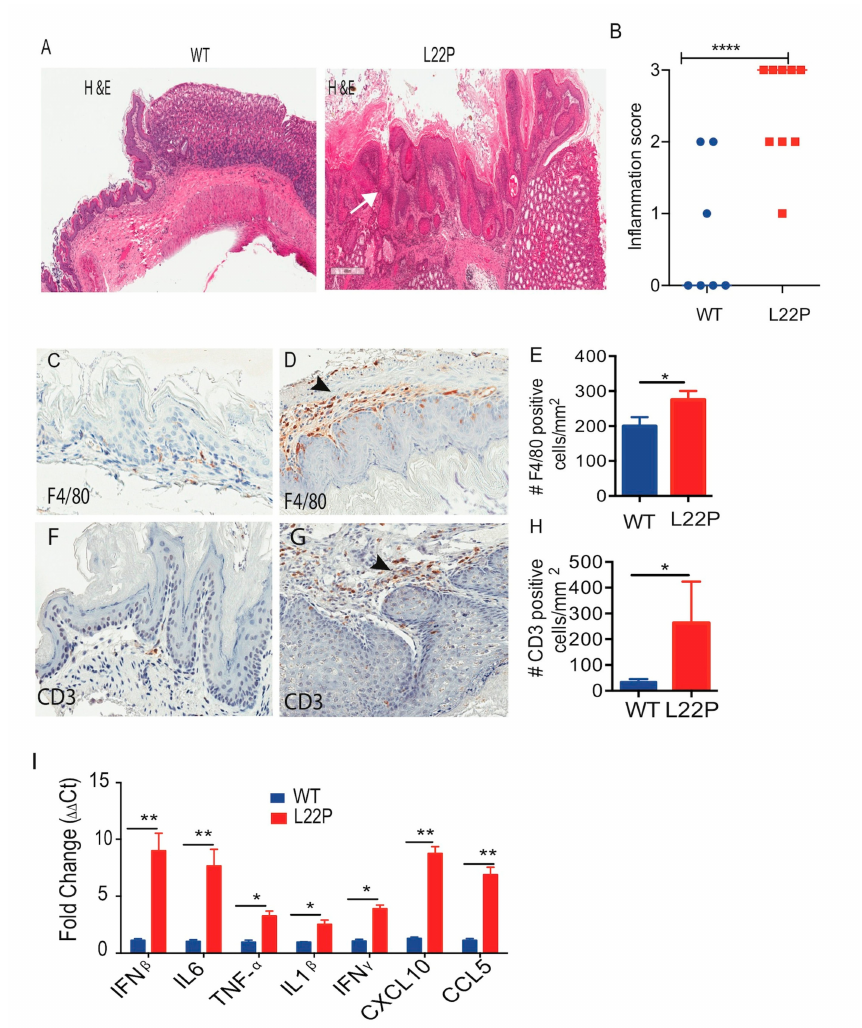
Figure 6. L22P increases susceptibility to gastric inflammation in mice. ( A ) Representative image of gastrichistopathologyofwildtype(WT)andL22PC57Bl / 6micewithHandEstaining; ( B )Quantification of inflammatory score between WT (seven mice) and L22P mice (nine mice) stomach tissue sections; Low-to-medium-grade inflammation with abundant lymphocytes and neutrophilic granulocytes in L22P